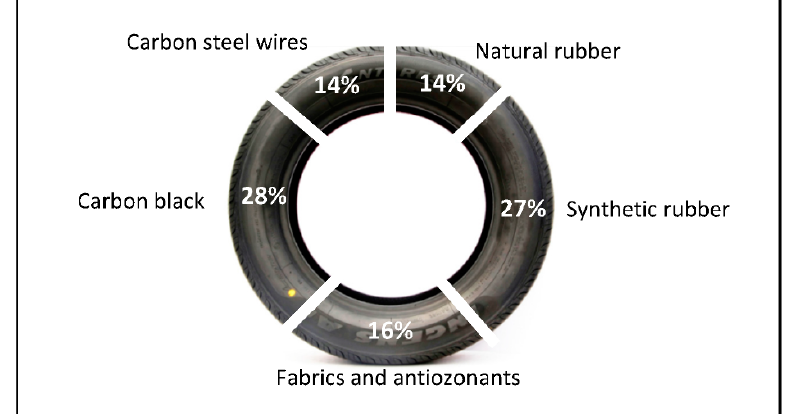
Figure 1. Typical composition of the tire.